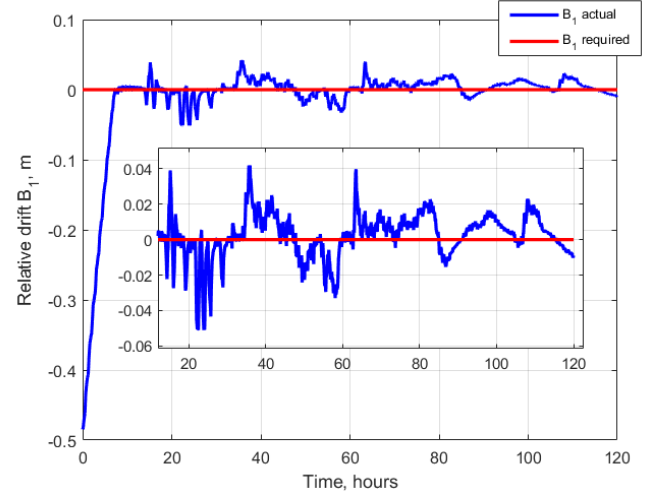
Figure 5. Relative drift.